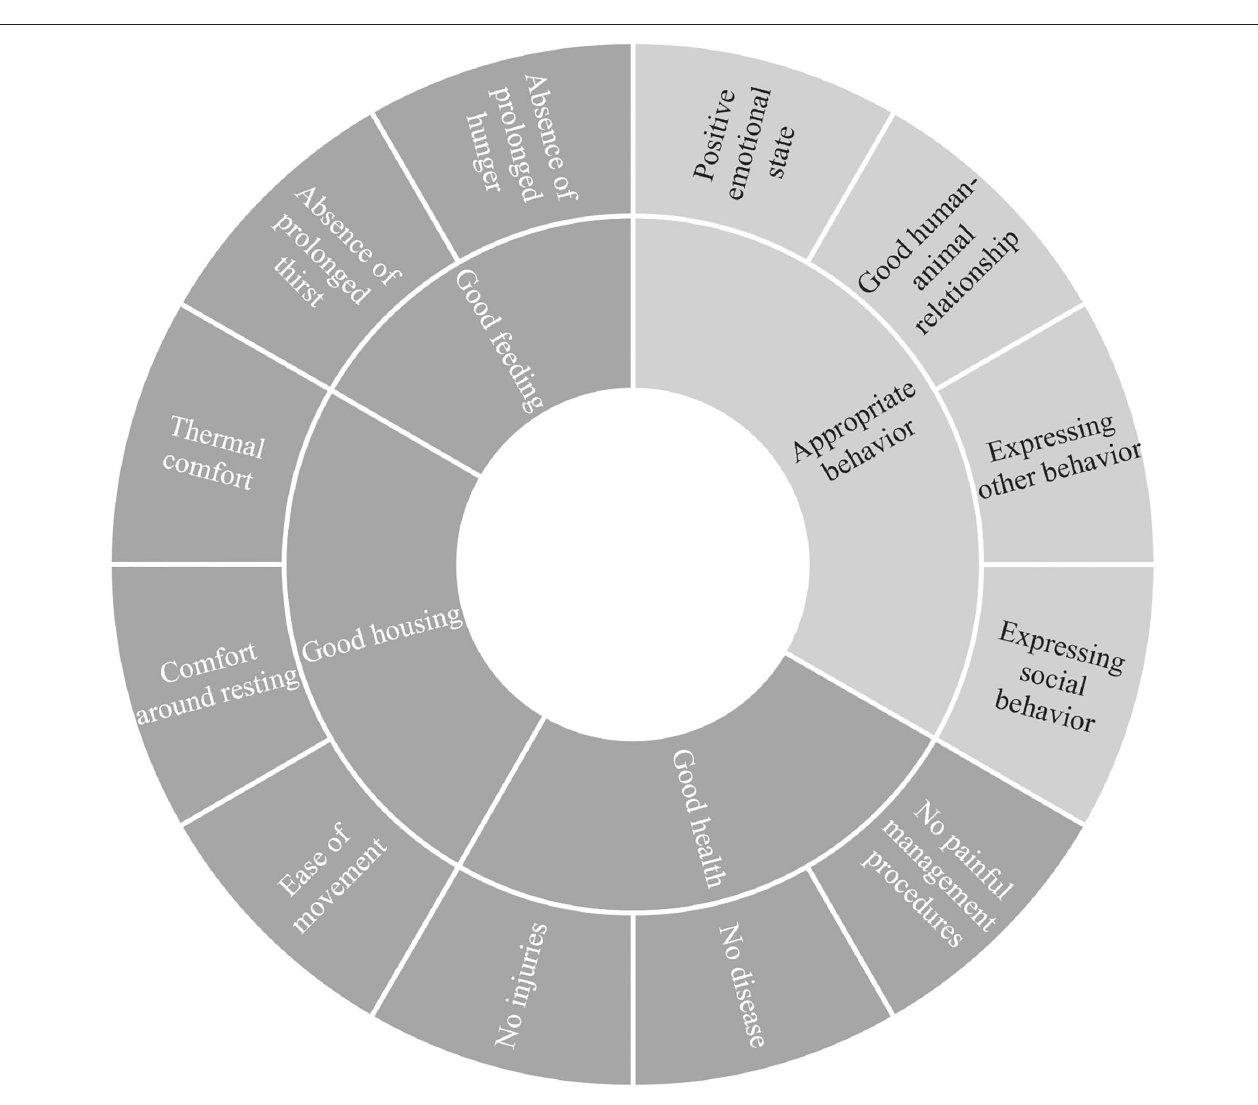
FIGURE 1 | Overview of the four Welfare Quality ® principles and its 12 criteria (modified after Blokhuis et al., 2013). The principle to assess behavior (“appropriate behavior”), which is the focus of the present study, is highlighted in light